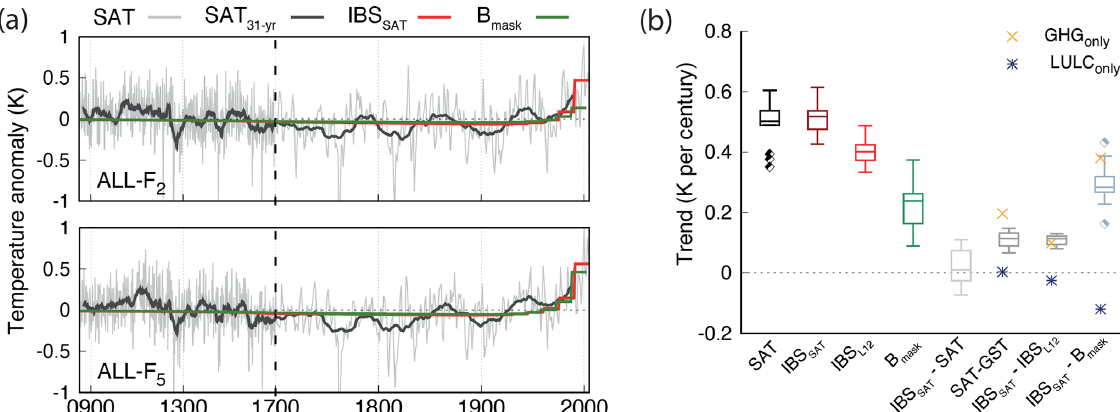
Figure 6. (a) LM global SAT annual anomalies and the corresponding 31-year filtered outputs and the global IBS SAT and B mask pseudo- reconstructions for the ALL- F 2 and ALL- F 5 members of the ALL- F ensemble. Note the different discretization in the x axis after 1700CE. (b) Estimated linear fit as Fig. 2b, but the SAT, IBS SAT , IBS L12 , B mask and the differences between IBS SAT − SAT, SAT − GST, IBS SAT − IBS L12 and IBS SAT − B mask cases are represented. Additionally, the ensemble medians of the GHG- and LULC-only ensembles are indicated by the crosses and asterisks, respectively, in the IBS SAT − IBS L12 and the IBS SAT − B mask